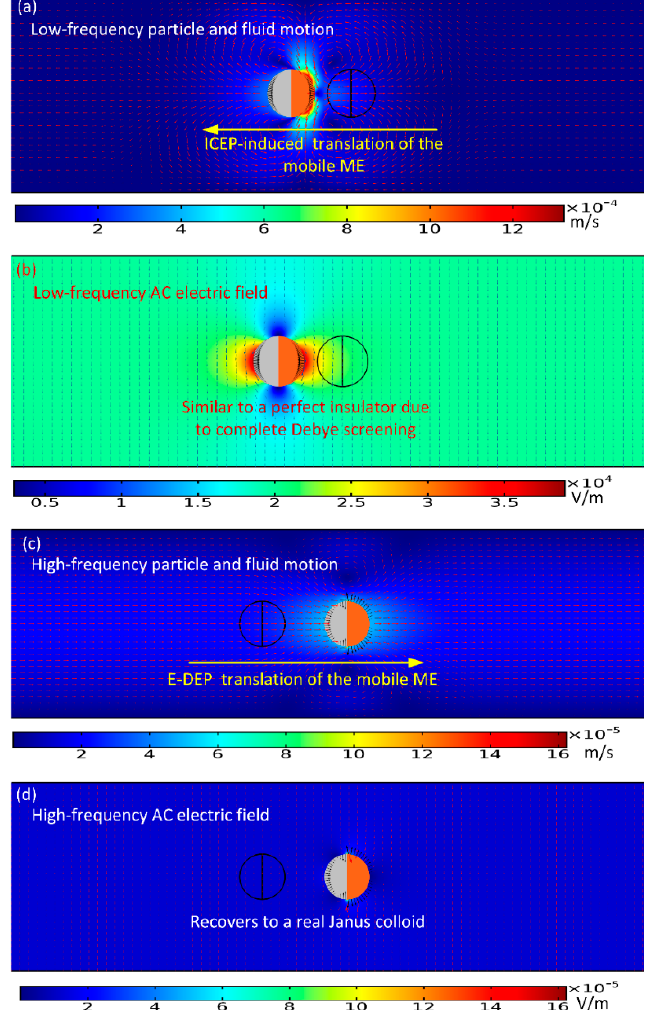
Figure 2. A simulation illustration of the electrokinetic delivery behavior of the Janus ME at distinct field frequencies under a given voltage amplitude of 1V. ( a , b ) In the low-frequency limit of f = 100 Hz and at a powering time of t = 0.1 s (See Supporting Video S1), ( a ) a surface and arrow plot of the ICEO-induced electrohydrodynamics (EHD) flow field and particle motion, and ( b ) an arrow and surface plot of the electric field around the Janus colloid of a symmetric induced dipole due to complete Debye screening on the conducting end. ( c , d ) In the high-frequency limit of f = 100 MHz and at a powering time of 1 s (See Supporting Video S2), ( c ) a surface and arrow plot of the ego-dielectrophoresis (e-DEP)-induced electrokinetic (EK) flow field and particle motion, and ( d ) an arrow and surface plot of the electric field around the Janus colloid of an asymmetric induced dipole due to the occurrence of electrochemical ion relaxation. The black arrows on the surface of the Janus particle (JP) in Figure 2 denote the interfacial Maxwell stress of a second-order voltage dependence.